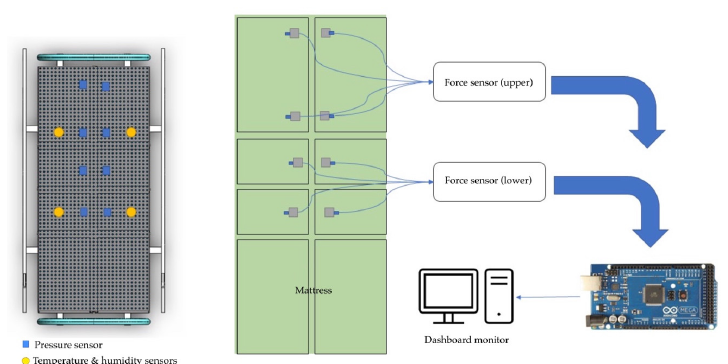
Figure 5. Functional mechanism.